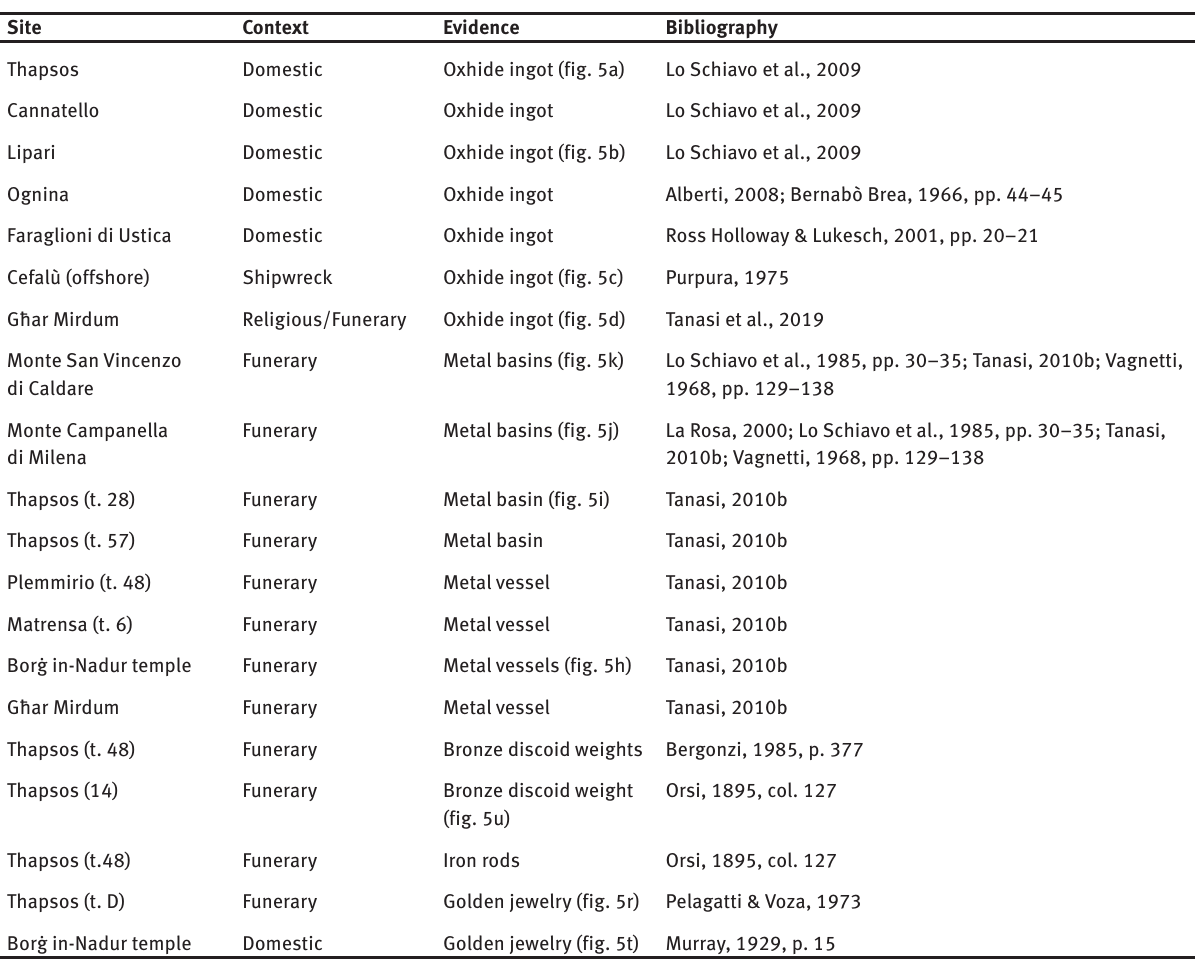
Table 4: Metals Artefacts of Mycenaean origin in Middle Bronze Age Sicily and